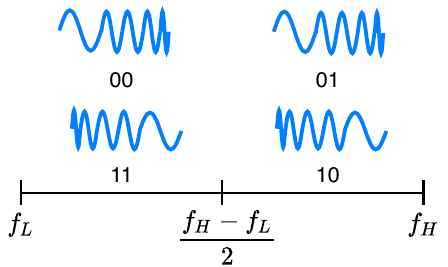
Figure 2. Up-down chirps used in each sub-band to encode four different symbols (quaternary